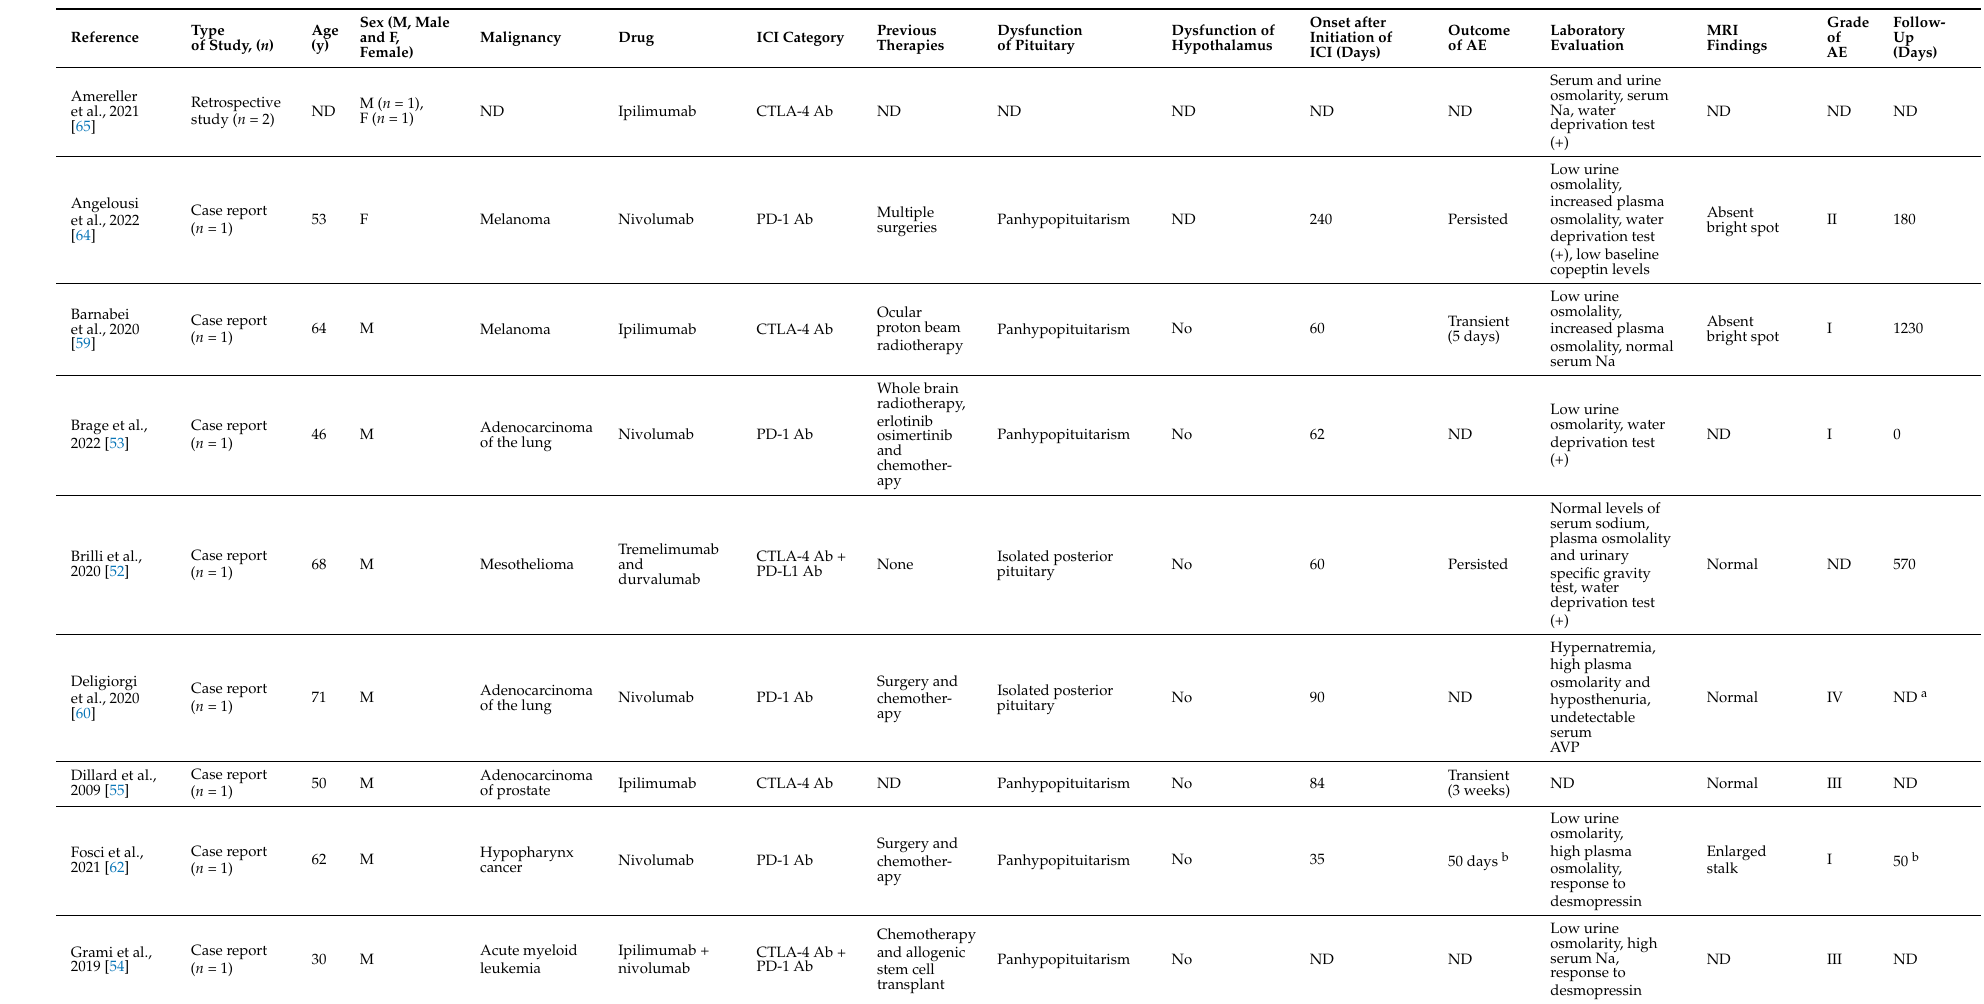
Table 2. Cases in the literature presenting with ICI-induced central diabetes insipidus